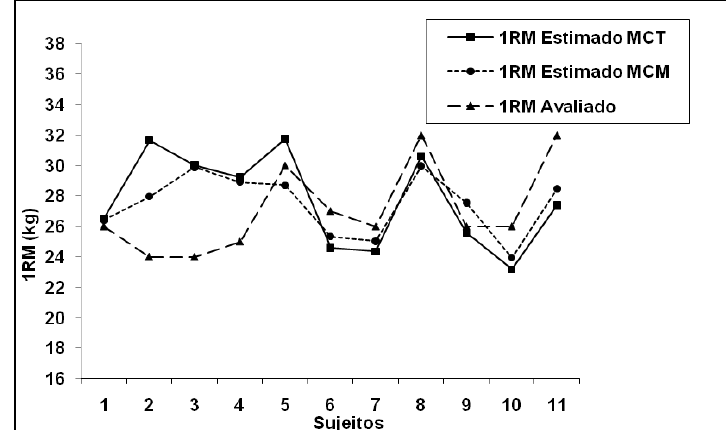
Figura 2- Diferença entre o 1RM avaliado (